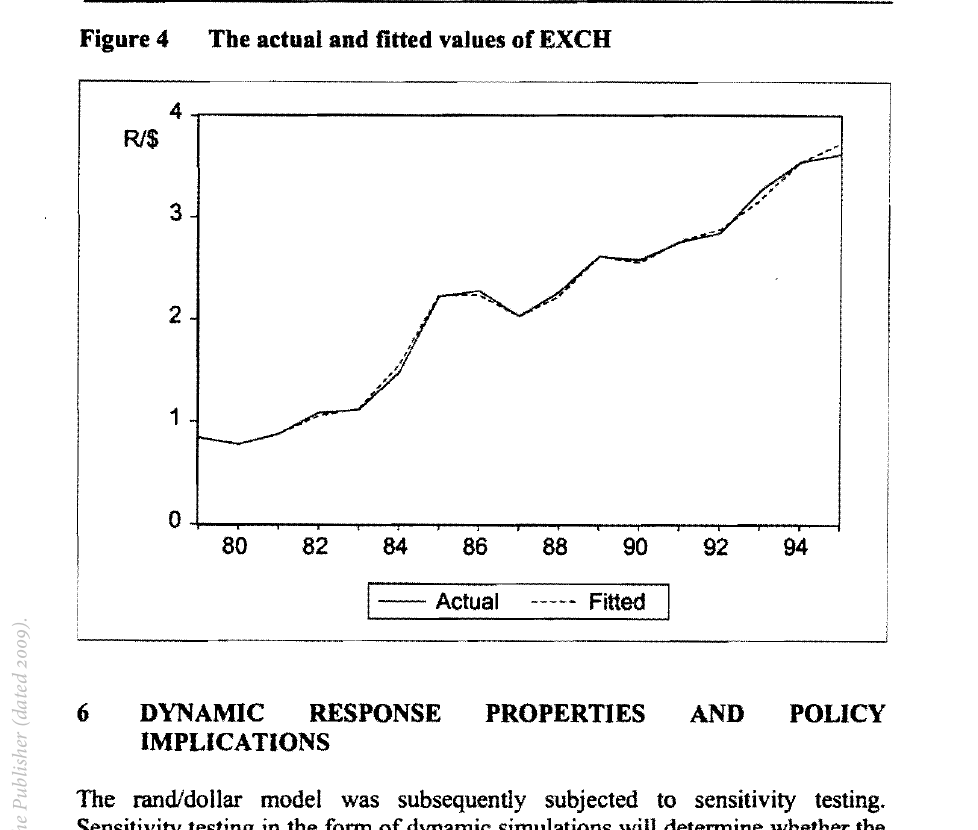
The actual and fitted values of